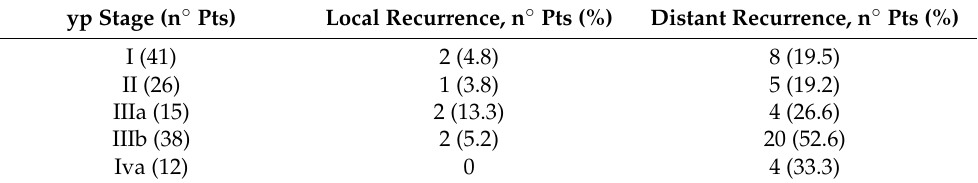
Local and distant recurrence occurred in 7.5% and 28.7% of patients, respectively ( p < 0.001). The principal sites of distal relapse were liver (23.6%), lung (21%), bone (15.7%) and brain, pleura, peritoneum, and distal nodes (5.2%). The median time to recurrence was 9 months (range 4–39 months). Recurrences are also clustered according to yp stage in Table 4. Table 4. Recurrence pattern according to yp stage. yp Stage (n ◦ Pts)